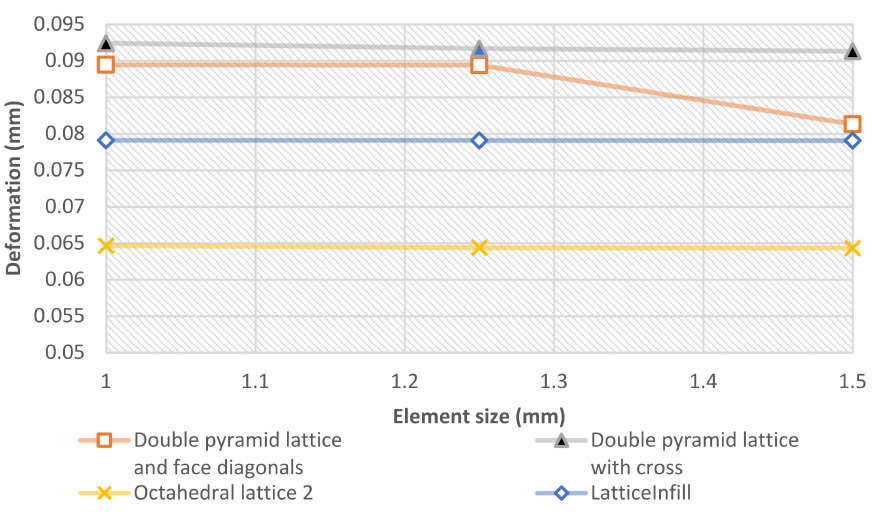
Figure 5. Results of the mesh convergence